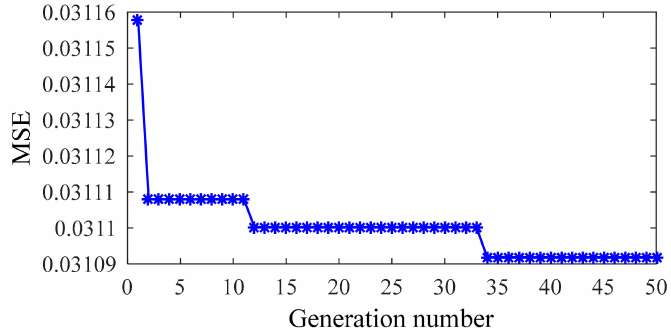
Figure 13. Iterative optimization process of